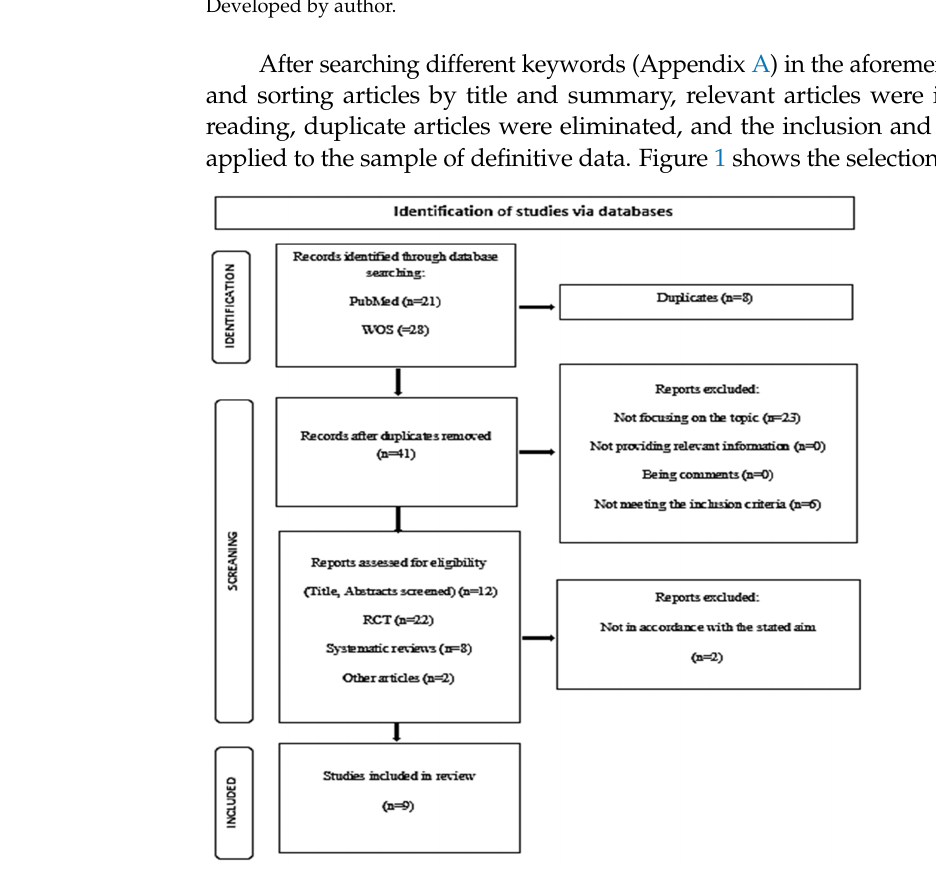
Figure 1. Flowchart showing the article selection. Developed by author following the guidelines of the PRISMA Guide 2021 [24].